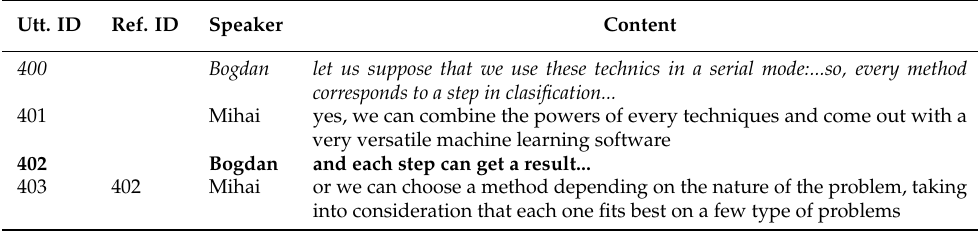
Table 12. Third example of wrong semantic link prediction ( explicit link / predicted link